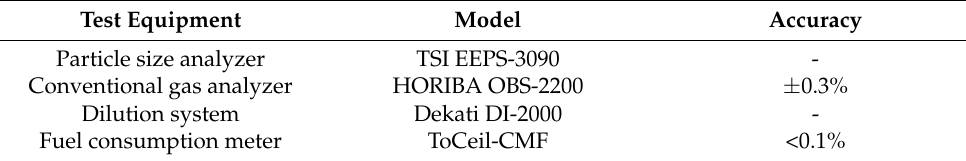
Table 3. Engine emission and fuel consumption testing equipment and models.